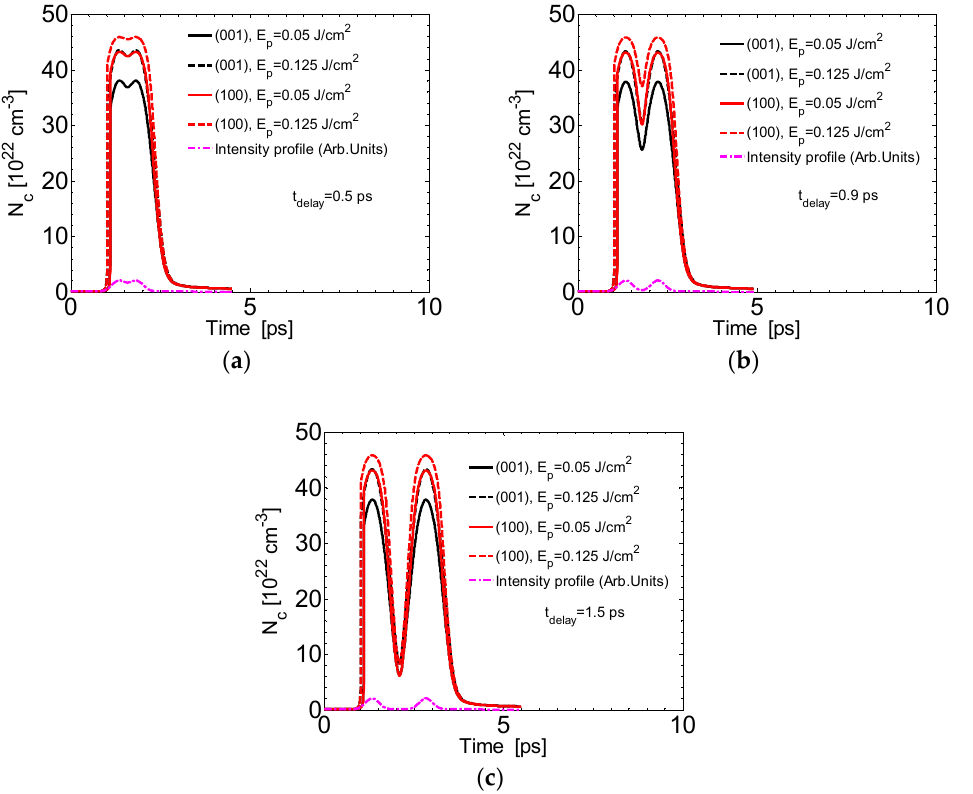
Figure 3. Evolution of carrier densities for E p = 50 mJ/cm 2 and 125 mJ/cm 2 for (001) and (100) crystal orientation at t delay = 0.5 ps ( a ), 0.9 ps ( b ), and 1.5 ps ( c ).